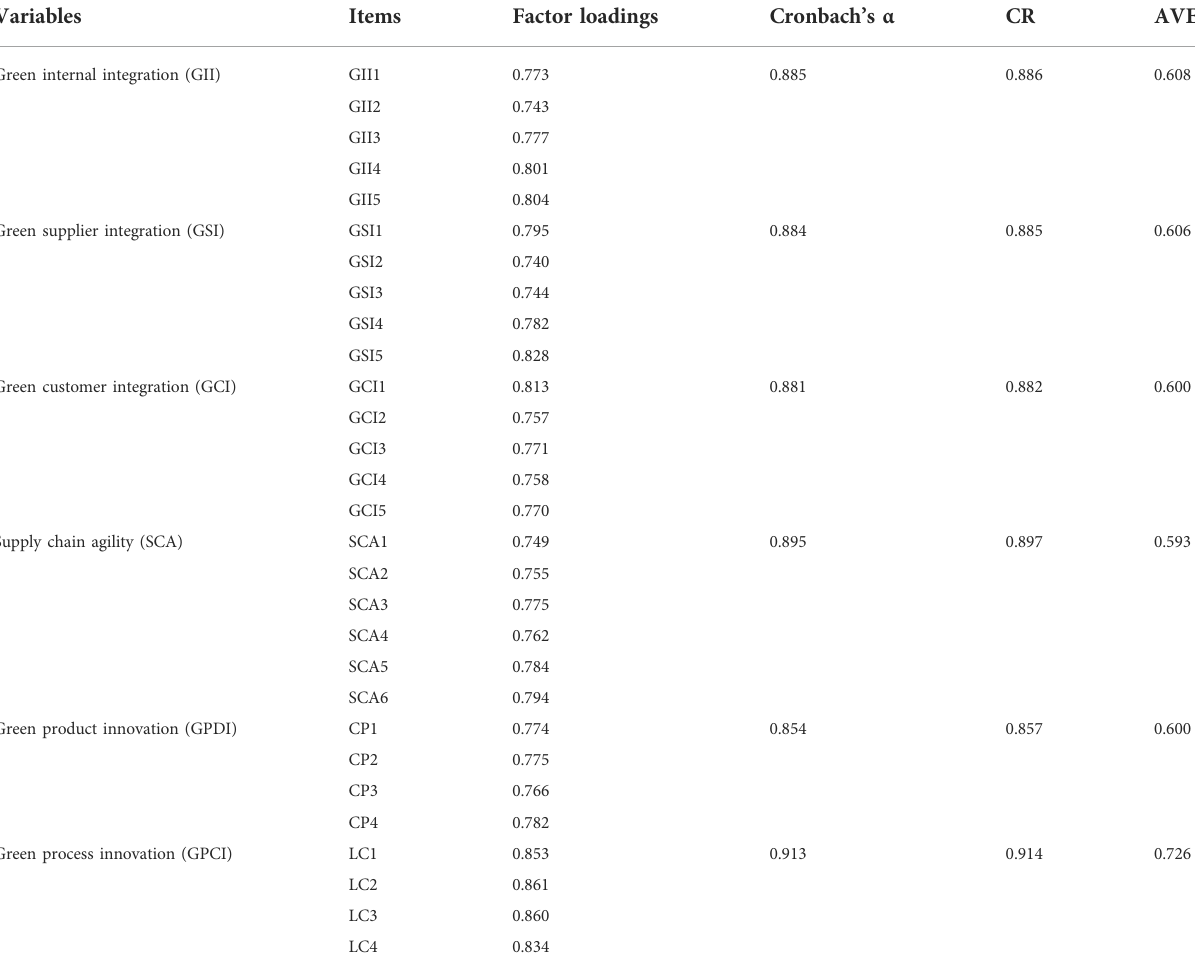
TABLE 2 Measurement reliability and